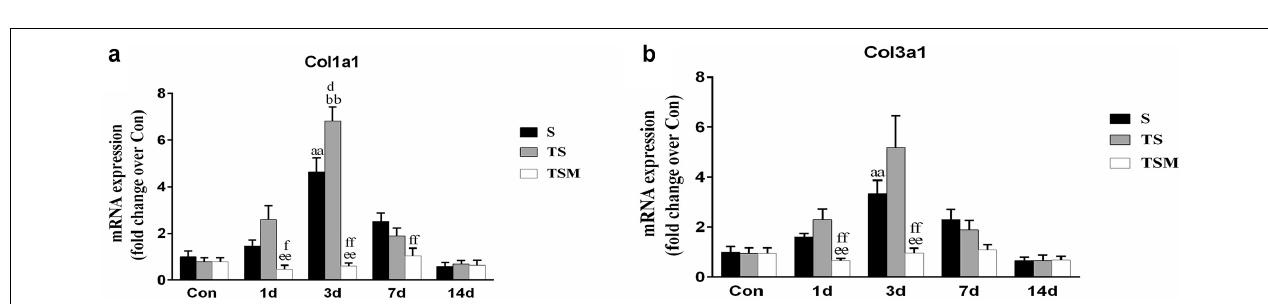
FIGURE 4 | Effects of MGF injection on muscle fibrosis after macrophage depletion at 14 days post-injury. (a) Muscle contusion group (14 days post-injury); (b) muscle contusion and macrophage depleted group (14 days post-injury); (c) muscle contusion, macrophage depletion, and MGF treated group (14 days post-injury); (d) quantification of the fibrosis area in GMs (14 days post-injury); Data are means ± SEM, n = 3. dd Significant difference from S14, p < 0.01; e Significant difference from TS14, p < 0.05. Scale bars = 200 µ m. Fibrosis tissues were shown in blue and muscle are in red .